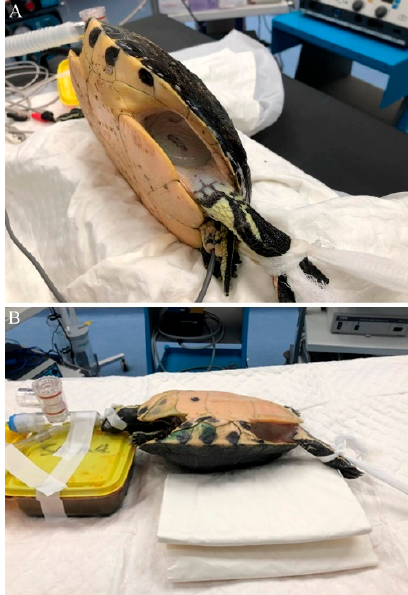
Figure 1. Patients placed in right lateral ( A ) and dorsal ( B ) recumbency, with their hindlimb extended to expose the prefemoral